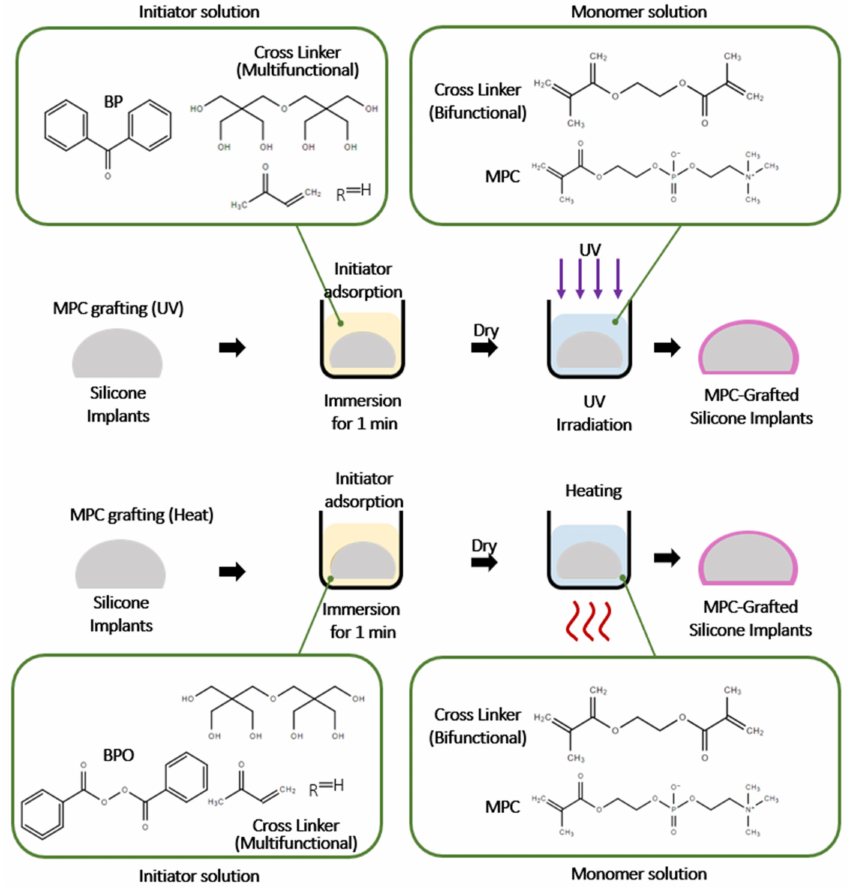
Figure 13. Surface grafting method of silicone implant with methacryloxyethyl phosphorylcholine (MPC). The polymerization grafting on the implants was conducted with 15 min-UV irradiation and 16 h heating at 70 ◦ C. Reproduced with permission from